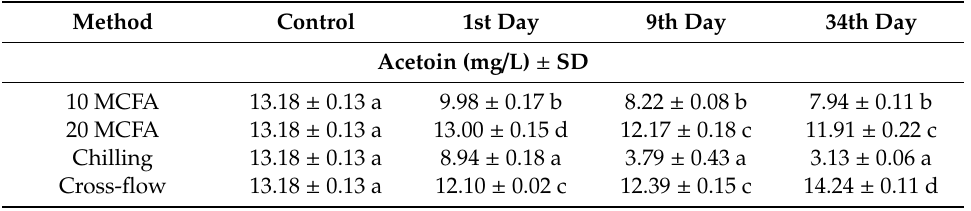
Figure 2. Changes in the acetoin content. Table 3. Changes in acetoin content. The average values ( n = 3) are supplemented by contribution into homogeneous groups (a, b, c, d) according to Fisher’s LSD (Least significant difference) test ( α = 0.05).